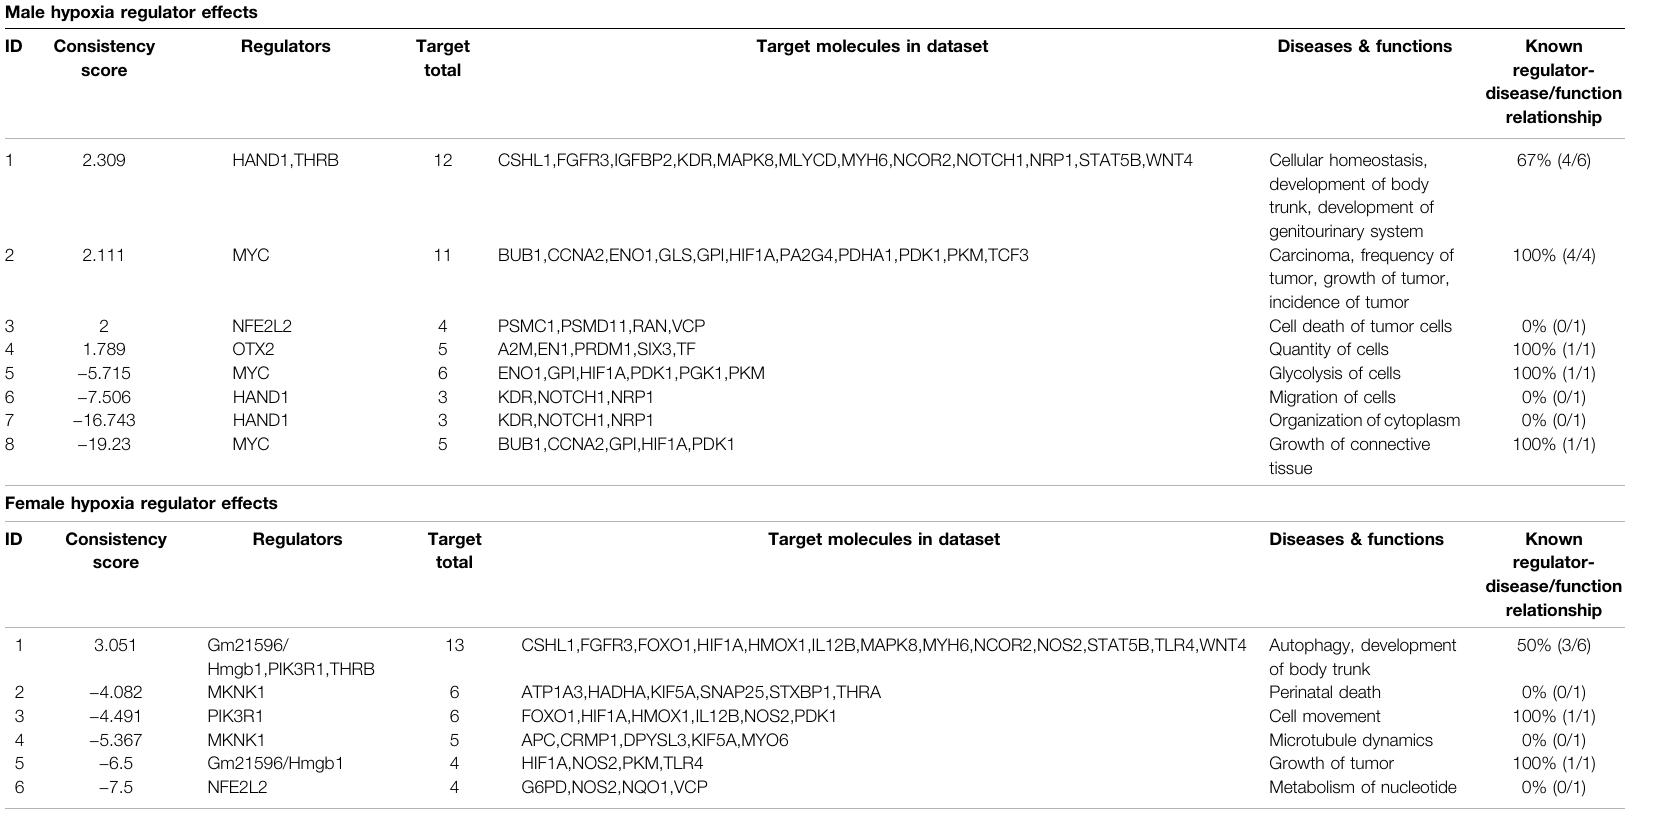
TABLE 3 | IPA generated regulatory effect analysis for male and female zebra fi sh brain proteome induced by hypoxia following recovery. Male hypoxia regulator